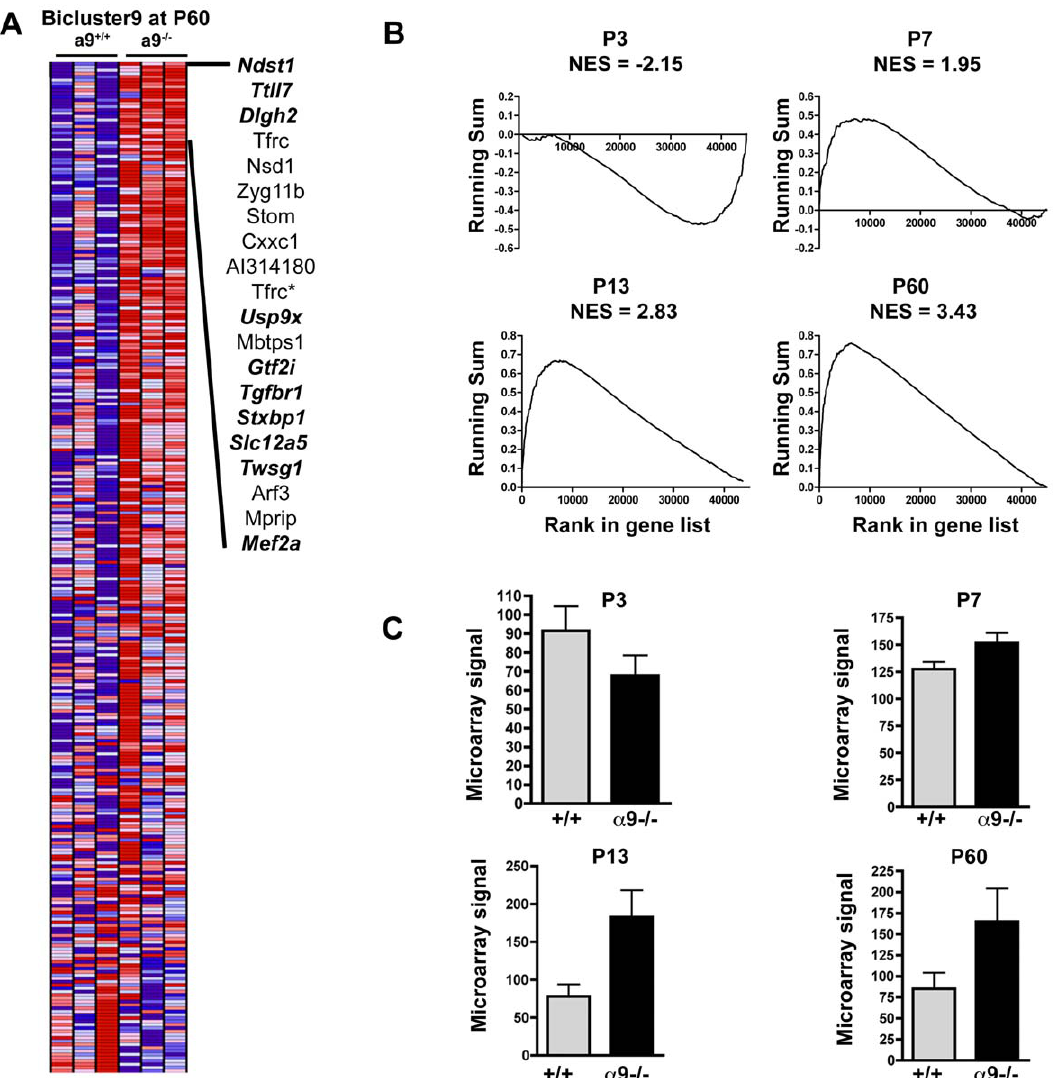
Figure 6. Gene set enrichment analysis of bicluster9 . ( A ) All the genes included in bicluster9 are represented as a heatmap ordered by their ranking in the gene list comparing the expression between wild type and a 9 2 / 2 at P60. The top 20 genes that contribute the most to the enrichment score are shown. An asterisk next to the gene name indicates that it is repeated twice because of probe mappings. Italicized genes in bold have previously known functional roles in the nervous system. Red indicates high expression; blue indicates low expression. ( B ) The running sum enrichment scores for bicluster9 are shown for each age. NES , normalized enrichment score. ( C ) Leading edge subset analysis for bicluster9 at each age. Normalized microarray signal values for wild type and a 9 2 / 2 animals are averaged over all genes in the leading edge subset at each time point. Error bars indicate SEM.